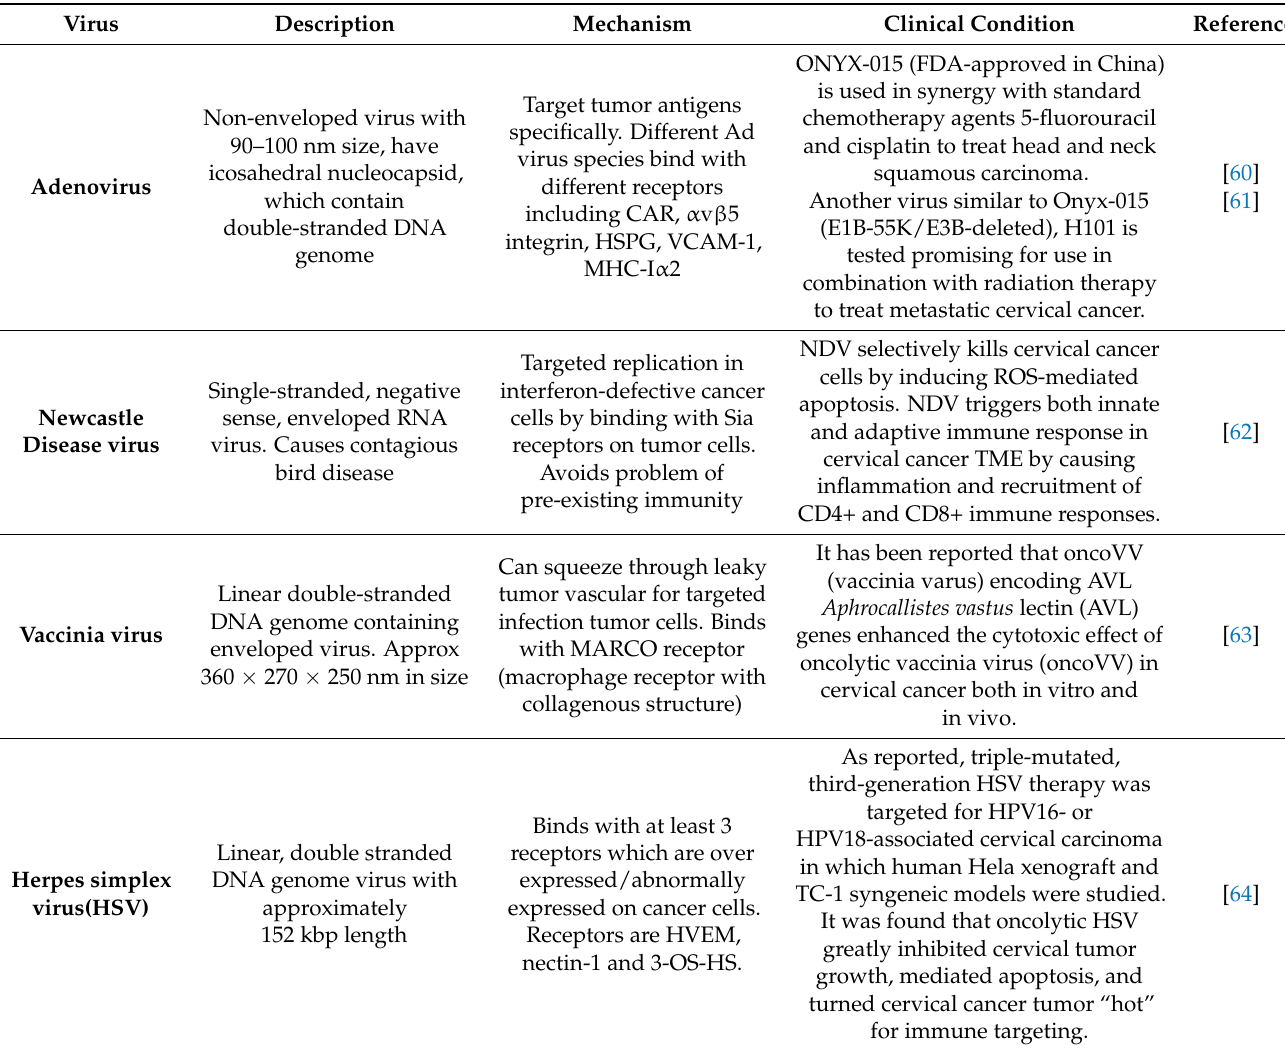
Figure 3. Oncolytic virus infection-mediated oncolysis of cervical cancer cells that leads to priming of both innate and adaptive immunity initiating a potent and viable immune response in tumor. Table 3. Oncolytic viruses being exploited for treatment of cervical